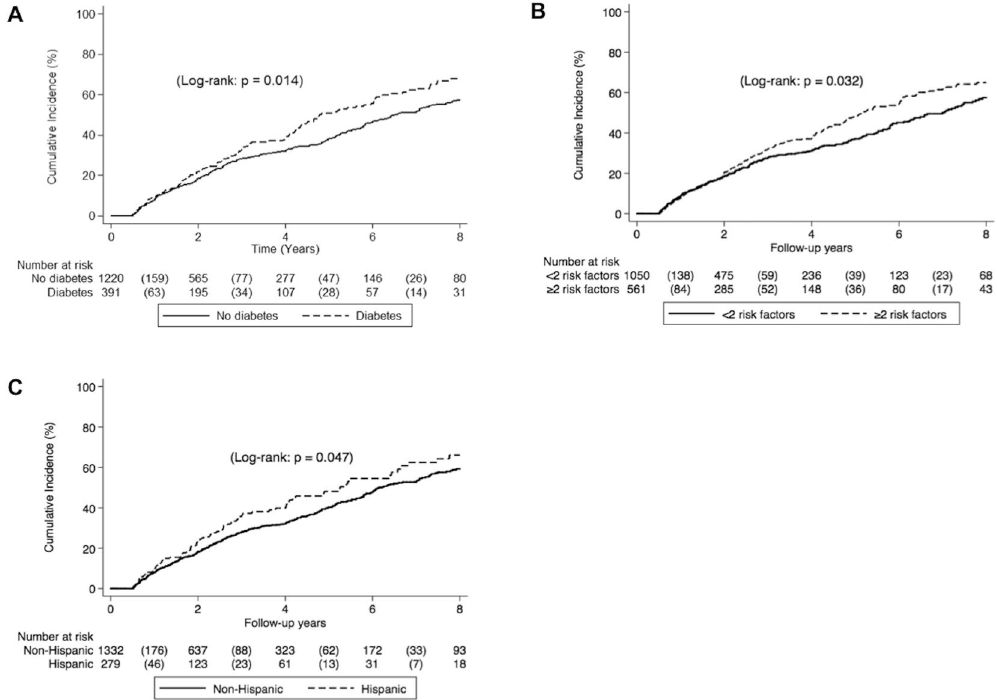
Figure 3. Incidence of hepatic decompensation by ( A ) diabetes status ( B ) number of metabolic risk factors and ( C ) Hispanic